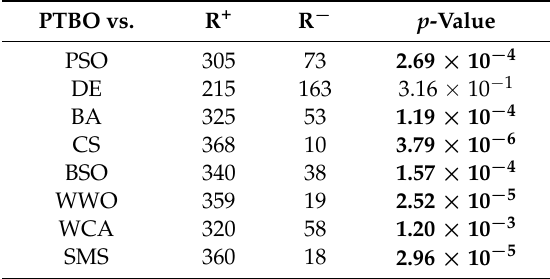
Table 12. Wilcoxon signed-rank test of 28 functions.